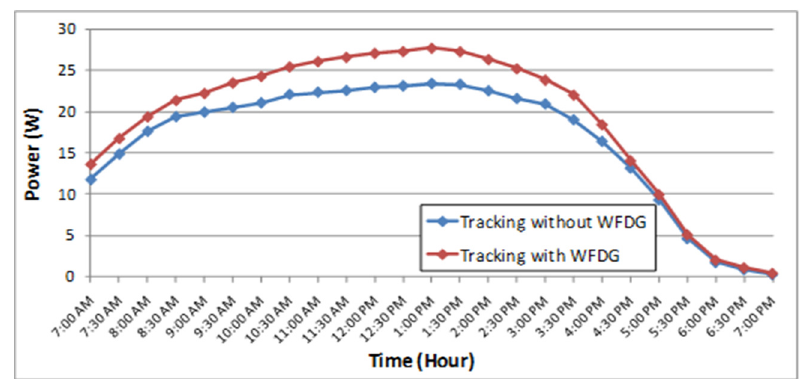
Fig. 8. Panel temperature through day time.